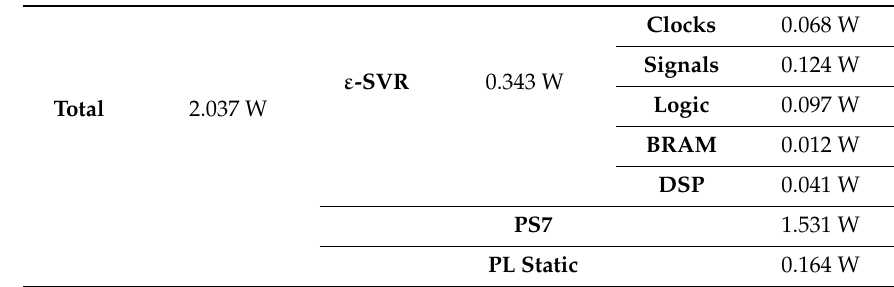
Table 5. System power consumption.